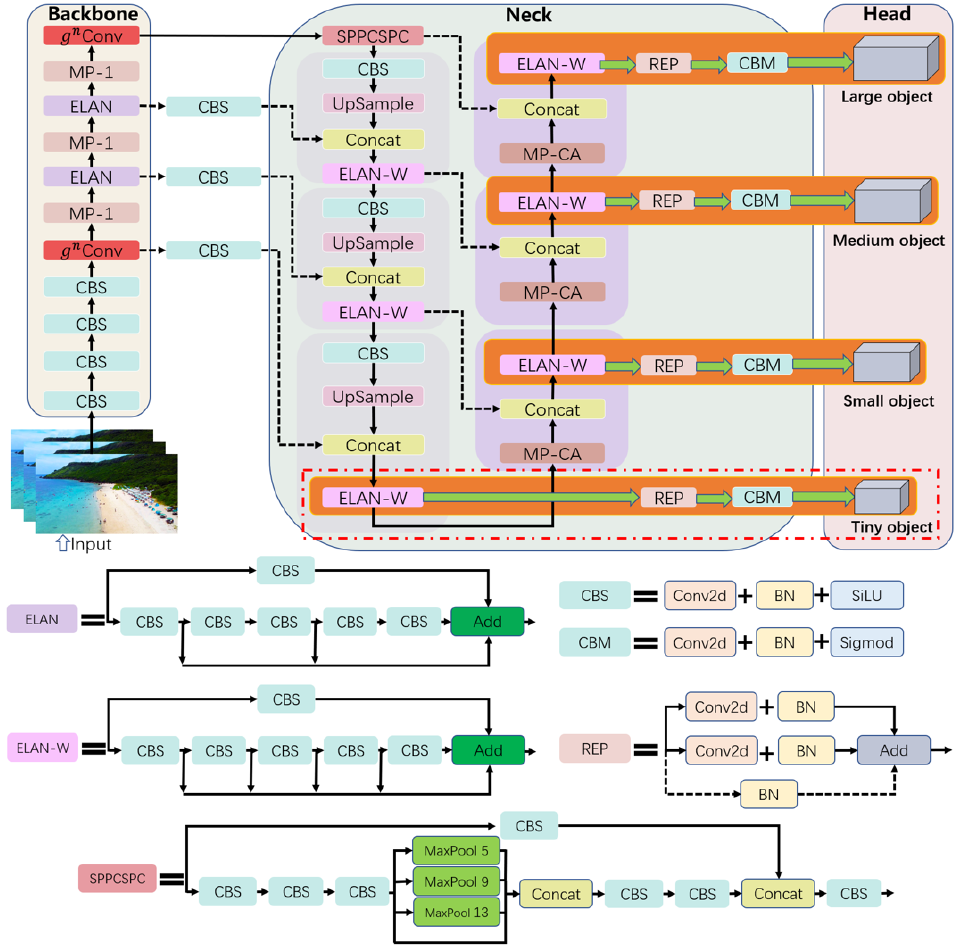
Figure 3. The network structure of TOD-YOLOv7. The red dotted box in the figure represents the extra detection head that this paper added to the model. The lower part of the figure illustrates the structural schematic diagram of specific